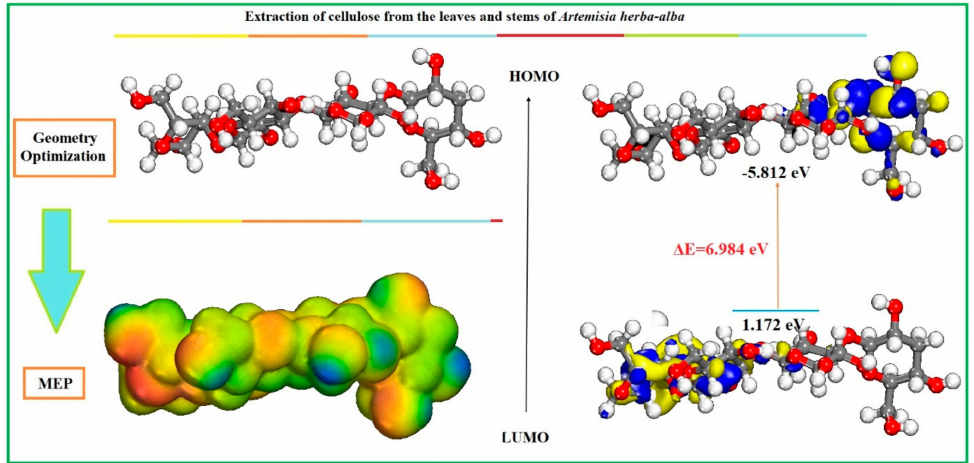
Figure 10. Optimized geometry, MEP pictures, and HOMO and LUMO for the cellulose molecule present in the leaves and stems of Artemisia herba-alba